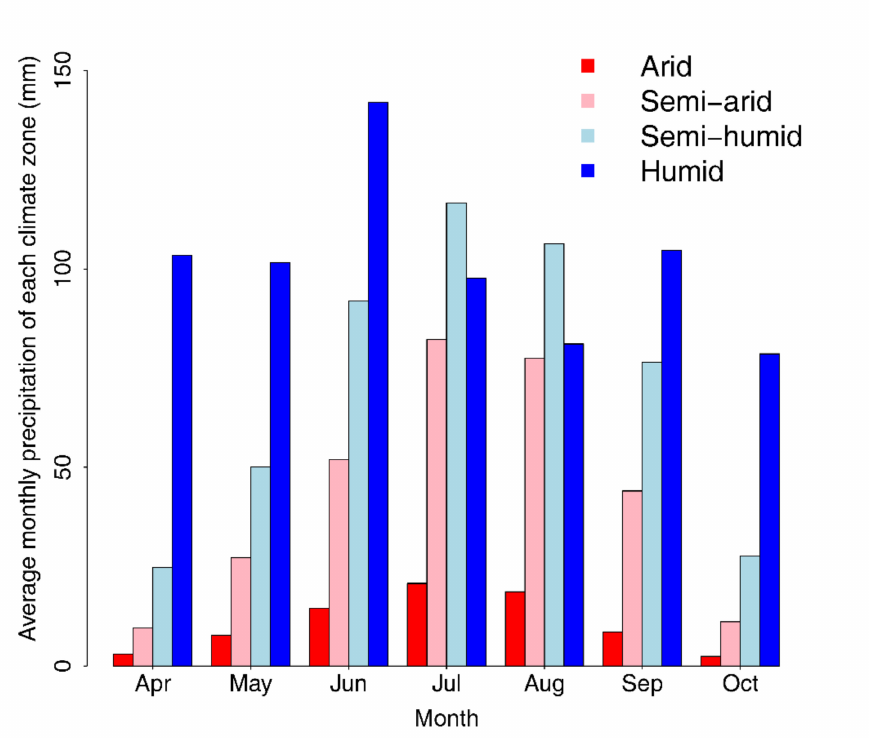
Figure A1. Mean monthly precipitation of each month in (May to September) and around (April and October) the growing season during the year from 1960 to 2015 for climatic zones based on the zoning of